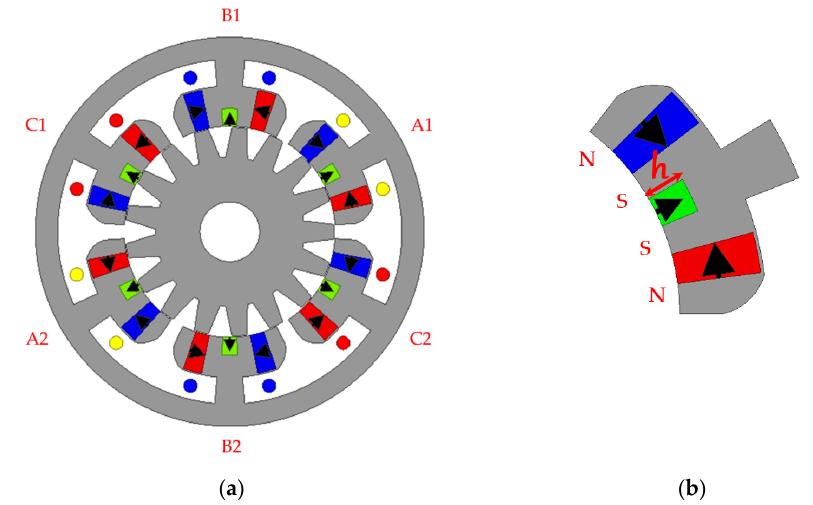
Figure 2. Proposed 6/17 E ‐ shaped stator tooth FSPM machine: ( a ) proposed 6/17 FSPM machine; ( b ) partial enlarged.